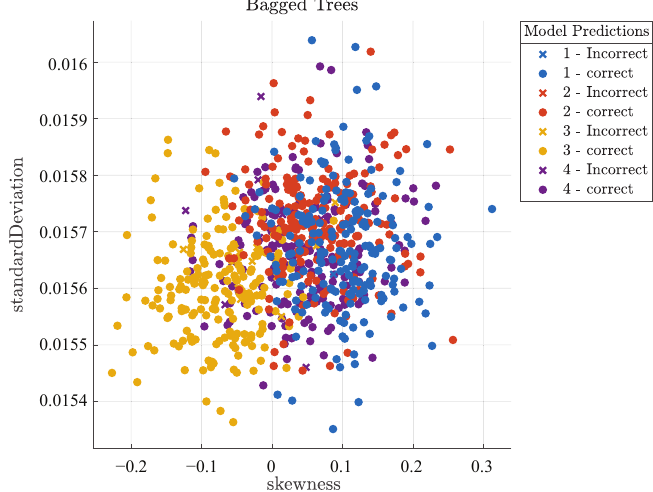
Figure 19. Scatter diagram of bagging.